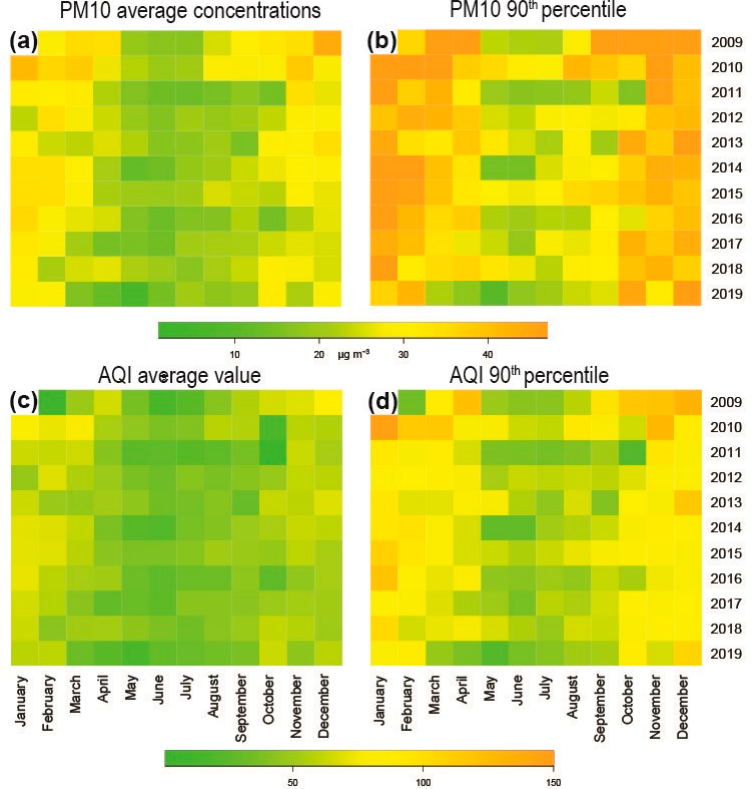
Figure 3. Temporal variation of ( a ) average of PM 10 concentration, ( b ) 90th percentile of PM 10 concentration ( µ g / m 3 ), ( c ) average of air quality index ( AQI ) and ( d ) 90th percentile of air quality index ( AQI ) in Cluj-Napoca city for 2009–2019.